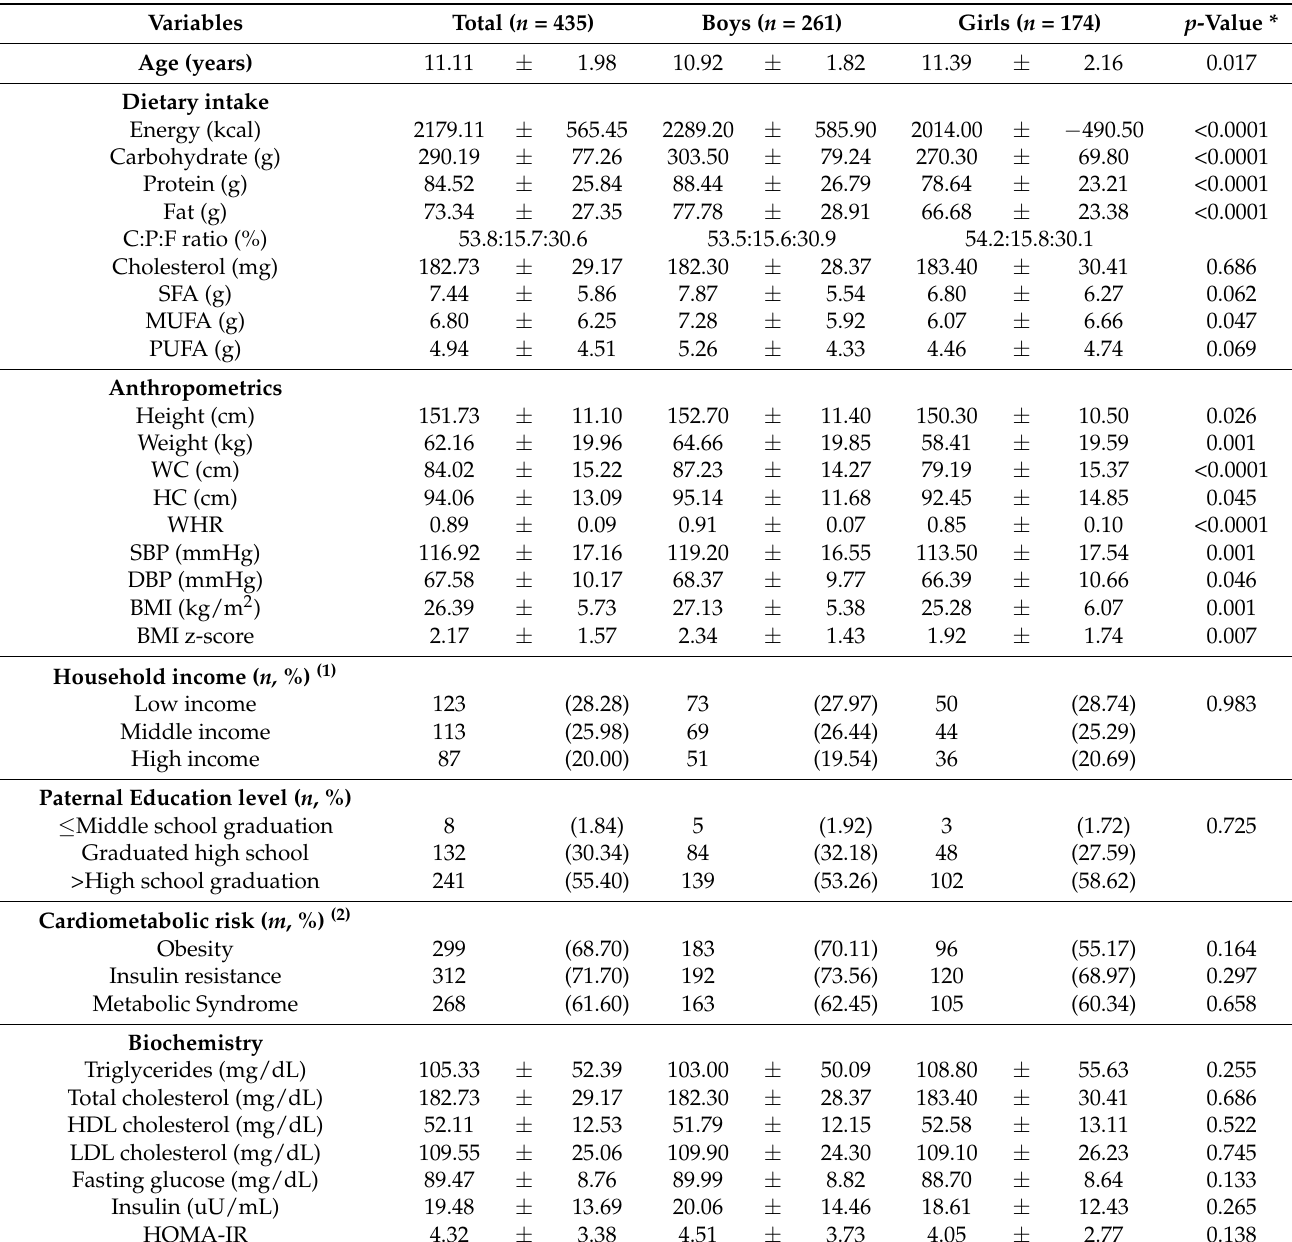
Table 1. General characteristics of Korean children and adolescents by